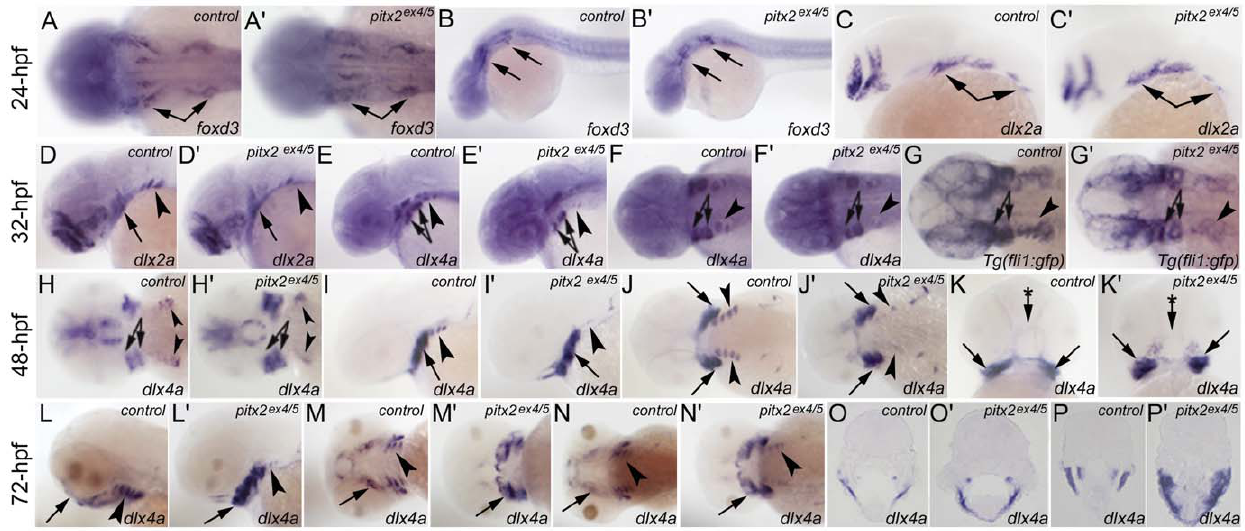
Figure 4. Craniofacial development and gene expression in pitx2 ex4/5 morphants. Developmental patterns of foxd3 , dlx2a and dlx4a , and Tg(fli1:gfp) expression in pitx2 ex4/5 embryos. In situ hybridization was performed with foxd3 , dlx2a , dlx4a or gfp -specific antisense riboprobe in control ( A–P ) or morphant ( A 9 –P 9 ) zebrafish embryos. Please note similar expression patterns in migrating neural crest cells ( foxd3 ) and pharyngeal arch primordial regions ( dlx2a ) at 24-hpf (arrows in control ( A–C ) and morphant ( A 9 –C 9 ) embryos). Starting at 32-hpf, expression of dlx2a , dlx4a and Tg(fli1:gfp) in the posterior arches appears to be reduced in pitx2 ex4/5 fish (arrowheads in control ( D–G ) and morphant ( D 9 –G 9 ) embryos) while expression in the anterior arches (arrows in control ( D–G ) and morphant ( D 9 –G 9 ) embryos) is not significantly affected. In 48–72-hpf embryos, an increased expression of dlx4a in the anterior arches is detected (arrows in control ( H–N ) and morphant ( H 9 –N 9 ) embryos) while expression in the posterior arches remains reduced (arrowheads in control ( H–N ) and morphant ( H 9 –N 9 ) embryos); dlx4a expression around the oral cavity in 48-hpf embryos (arrow with asterisk in K and K 9 ) as well as a frontward extension of the anterior arches at 72-hpf (arrows in L–N for controls and L 9 –N 9 for morphants) are not observed in pitx2 ex4/5 fish. Analysis of sections at 72-hpf also shows broadened expression of dlx4a in the craniofacial region of morphant embryos ( O 9 , P 9 ) in comparison to controls ( O, P ).